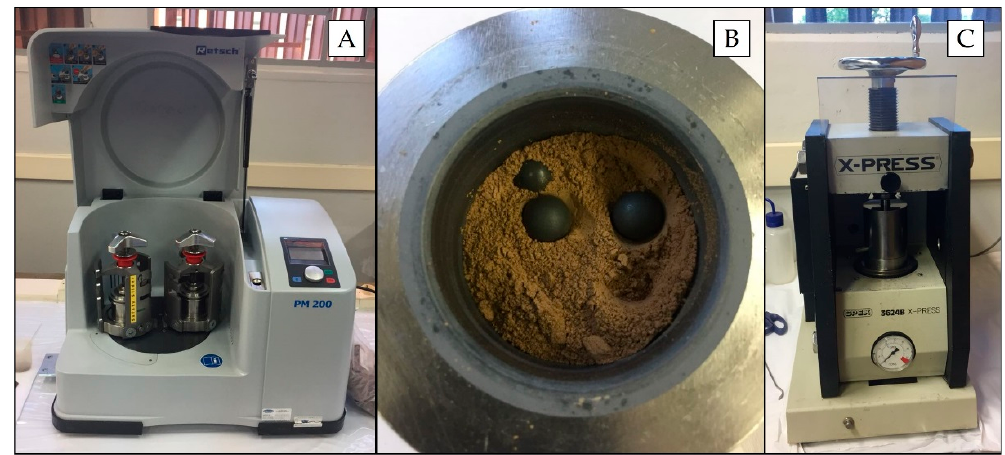
Figure 1. Planetary ball mill ( A ), loose soil inside the tungsten carbide jars with the tungsten carbide balls ( B ) and hydraulic press ( C ), which were used at work.